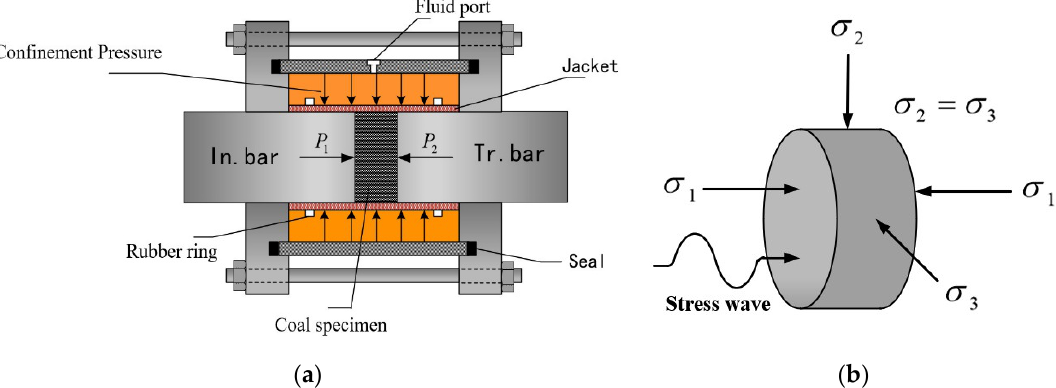
Figure 4. Confining device: ( a ) Schematic diagram of the confining device; ( b ) Schematic diagram of triaxial dynamic loading of coal specimen.